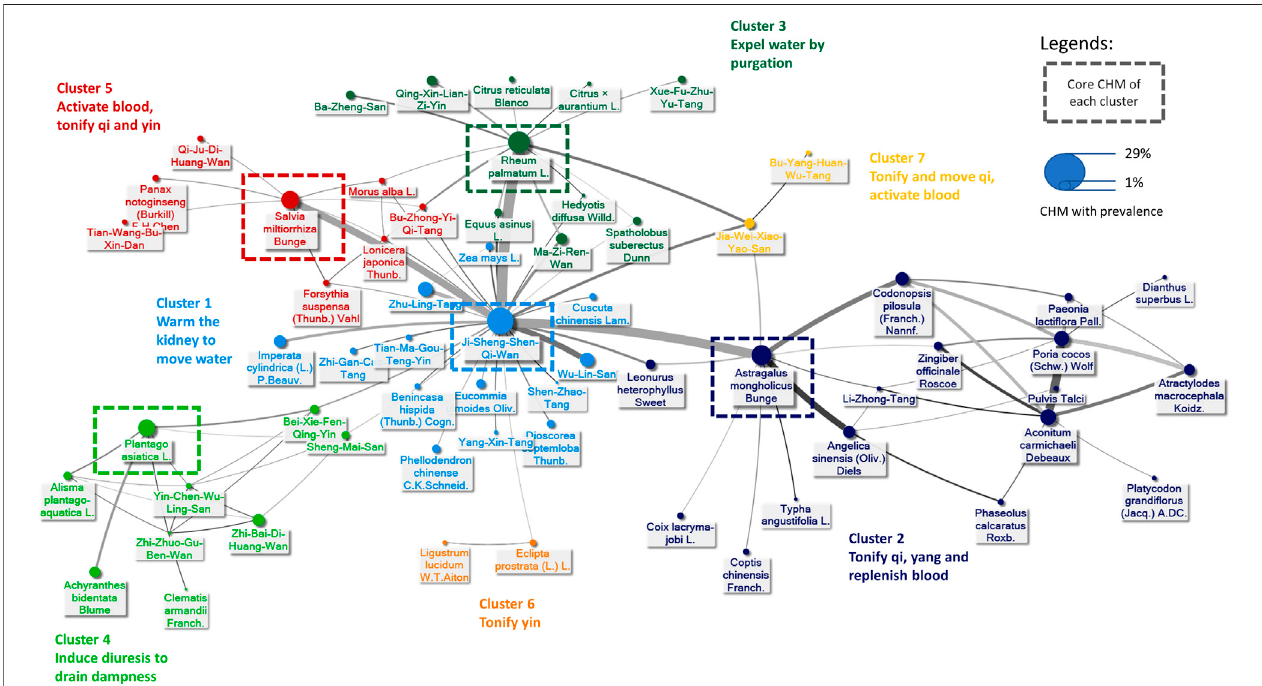
FIGURE 5 | Graphic demonstration of the Chinese herbal medicine (CHM) for pre-dialysis DN patients. The connections between every CHM formed the Chinese herbalmedicinenetwork(CMN),inwhichthickeranddarkerlinesmeanshigherprevalenceandstrongerconnections.CHMswithcloserrelationshipsweregatheredinto different clusters, presented by using different colors. The full name of CHMs is listed in Supplementary File S2 , and the composition of herbal formula (HF) is listed in Supplementary File S3 .